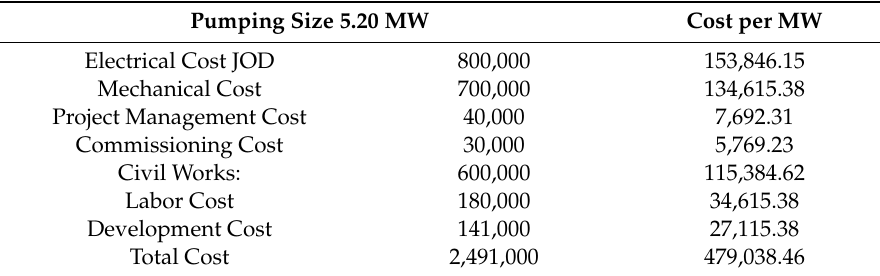
Table 3. Estimated cost for pumping system.